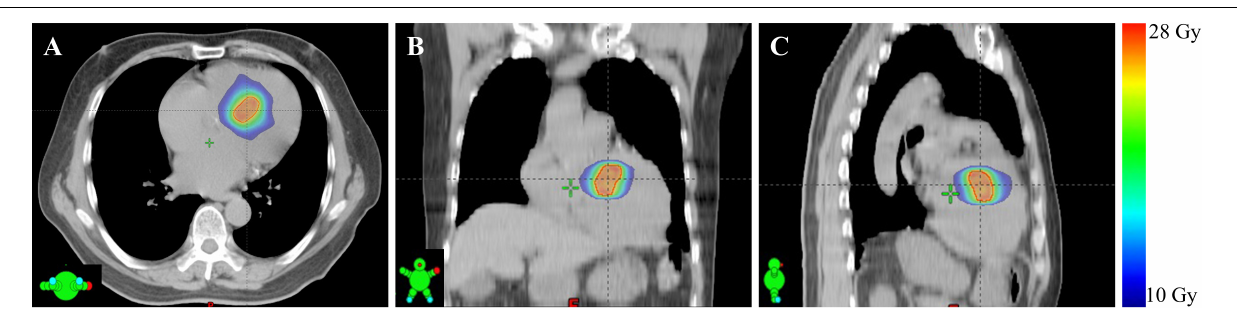
FIGURE 2 | Dose distribution is shown with representative computed tomography (CT) simulation scans in the axial (A) , coronal (B) , and sagittal (C) planes.